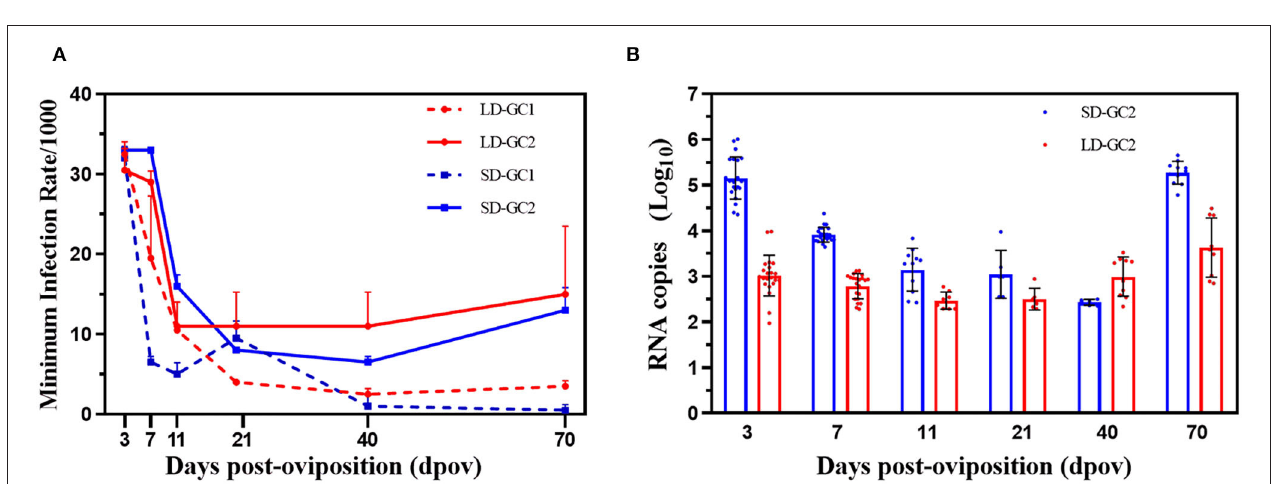
FIGURE 3 | Minimum infection rates and RNA copy number of Zika virus in Aedes albopictus mosquitoes on 3, 7, 11, 21, 40, and 70 days post-oviposition. (A) Minimum infection rates/1,000 is the ratio of the number of positive pools to 1,000 eggs tested. Red dotted lines indicate the MIRs in the first gonotrophic cycle under long-day photoperiod. Red solid lines depict the MIRs in the second gonotrophic cycle under long-day photoperiod. Blue dotted lines indicate the MIRs in the first gonotrophic cycle under short-day photoperiod. Blue solid lines depict the MIRs in the second gonotrophic cycle under short-day photoperiod. Error bars indicate SDs. (B) Zika virus RNA copy number in egg pools on 3, 7, 11, 21, 40, and 70 days post-oviposition. Each point represents one positive pool. Red dots indicate RNA copy number in the second gonotrophic cycle under long-day photoperiod. Blue dots indicate RNA copy number in the second gonotrophic cycle under short-day photoperiod. Error bars indicate